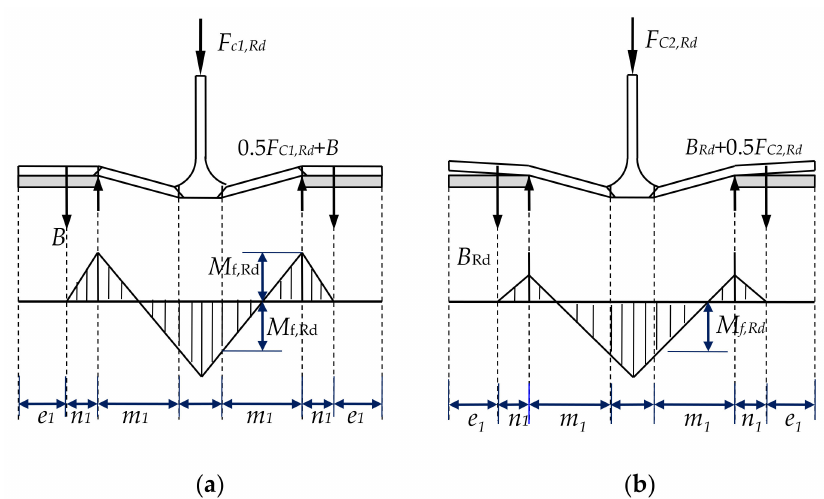
Figure 2. Failure mechanisms of T-stub connections with inserted plates under compression, which can be categorized as: ( a ) Type 1 failure mode; ( b ) Type 2 failure